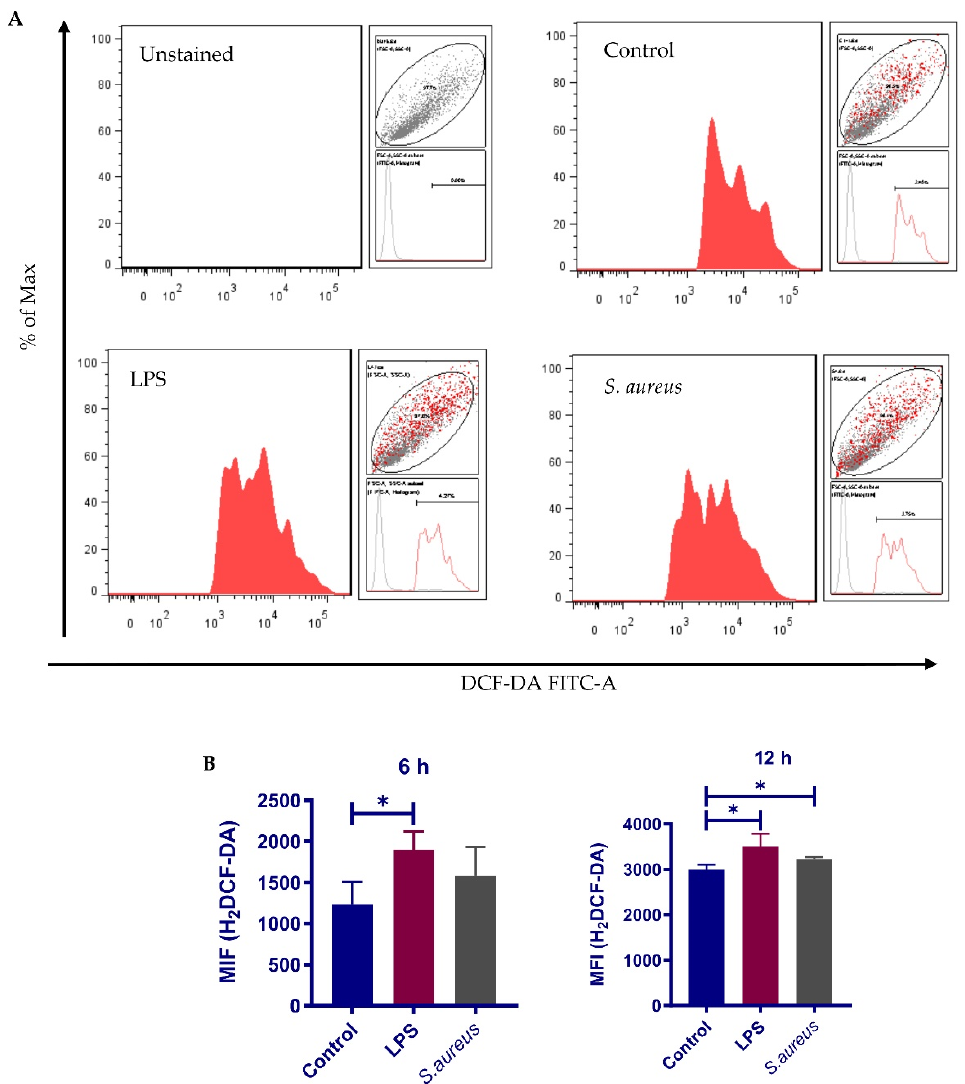
Figure 8. Determination of the production of ROS using the 2’,7’-dichlorofluorescin diacetate (DCF-DA) probe. pbMECs were treated with LPS (10 µ g/mL) or S. aureus (1 × 10 7 particles/mL) for 6 and 12 h, followed by incubation with serum-free medium containing H2DCF-DA (20 µ M) for 30 min. 2,7-dichlorofluorescein (DCF) fluorescence was measured using flow cytometry. ( A ) Representative flow cytometry histograms showing DCF-DA staining of cells treated with LPS or S. aureus for 12 h. ( B ) Mean fluorescence intensities (MIF) are shown as bar graph. Data are mean ± s.d. ( n = 3). * p <